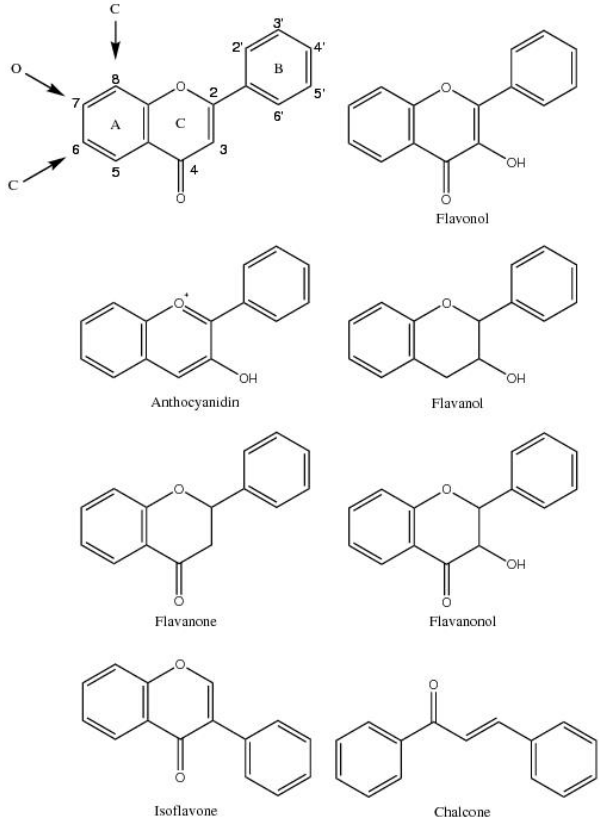
Figure 1. The generalised structure and numbering of flavonoid compounds based on the flavone skeleton (top left) and the generalised structure of various classes of flavonoids.